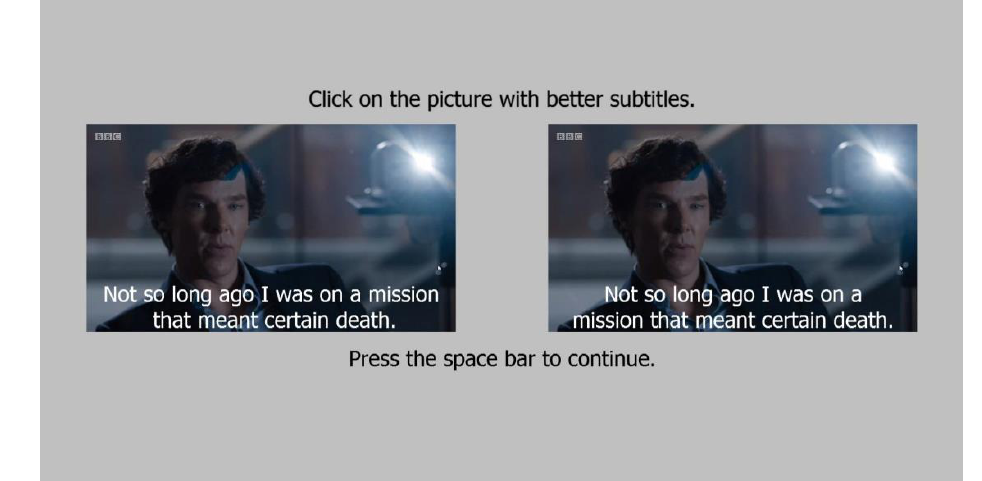
Figure 1. Stimulus example with syntactically segmented (left) and non-syntactically segmented text